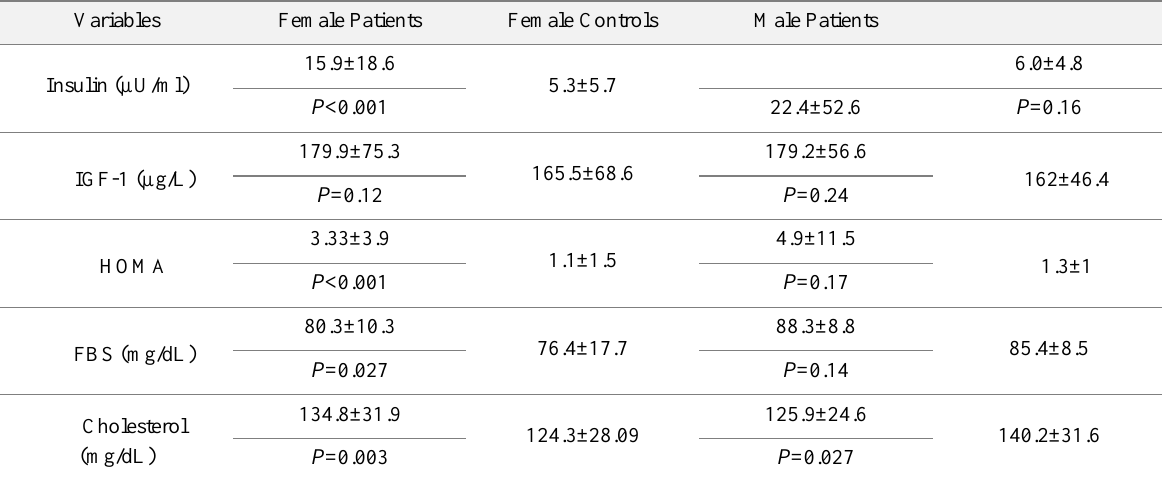
Table 2. Characteristics of males and females in both groups of patients and